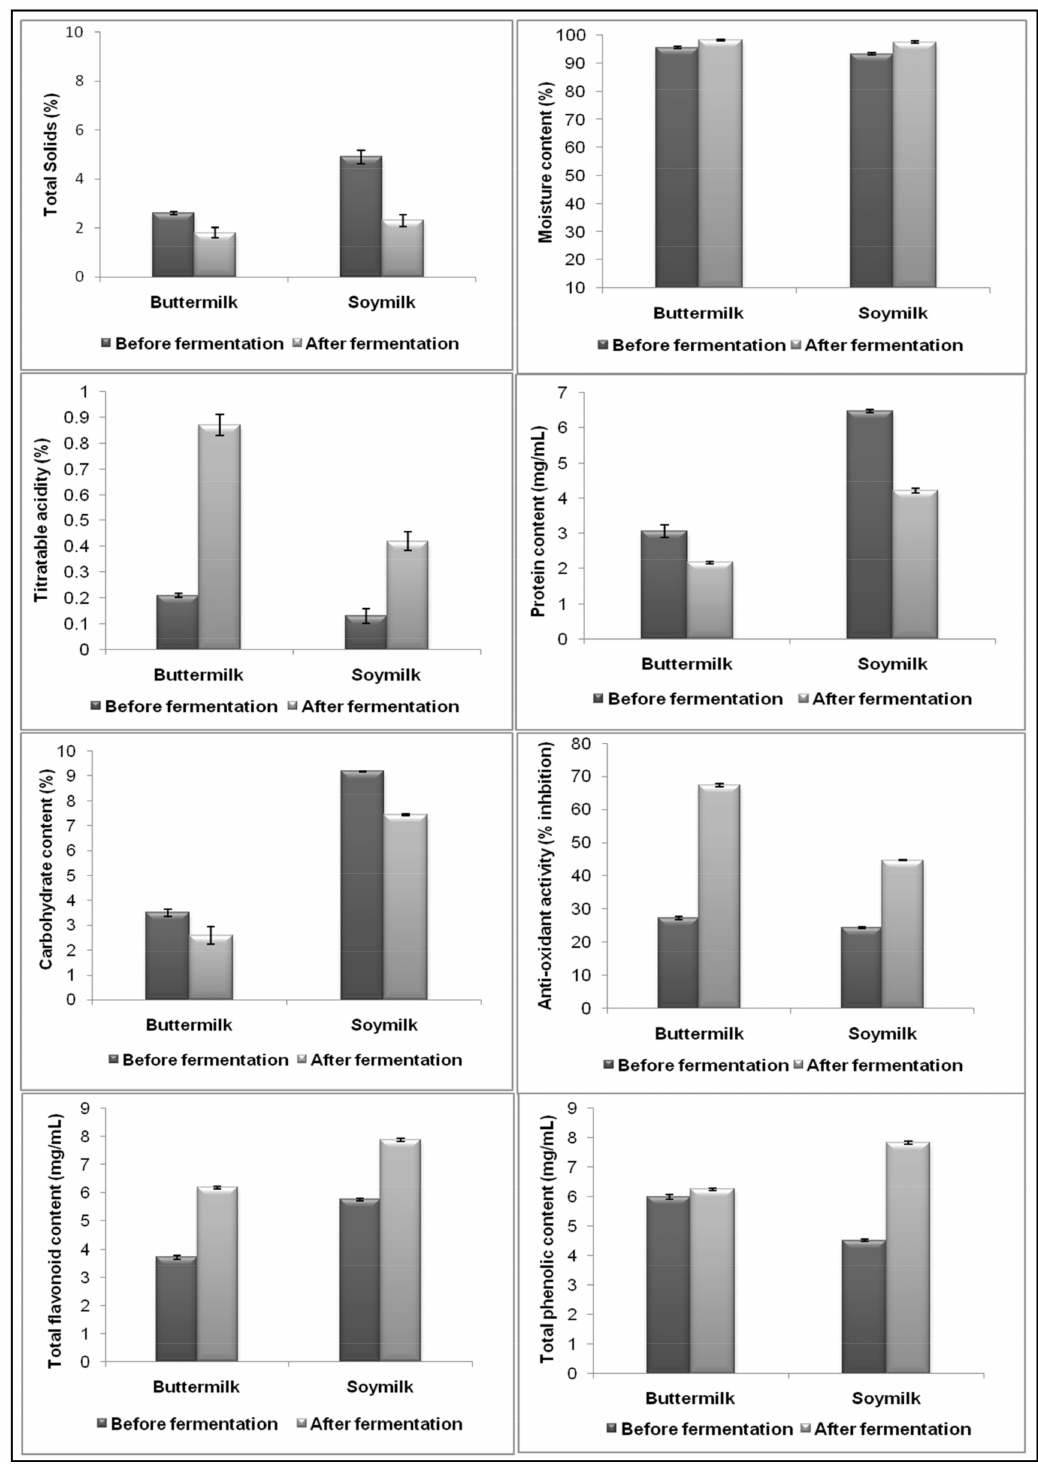
Figure 2. P. acidilactici BD16 ( alaD + ) induced variations inphysicochemical attributes of buttermilk and soymilk. Values are presented as mean ± standard deviation (SD) of triplicates (n =